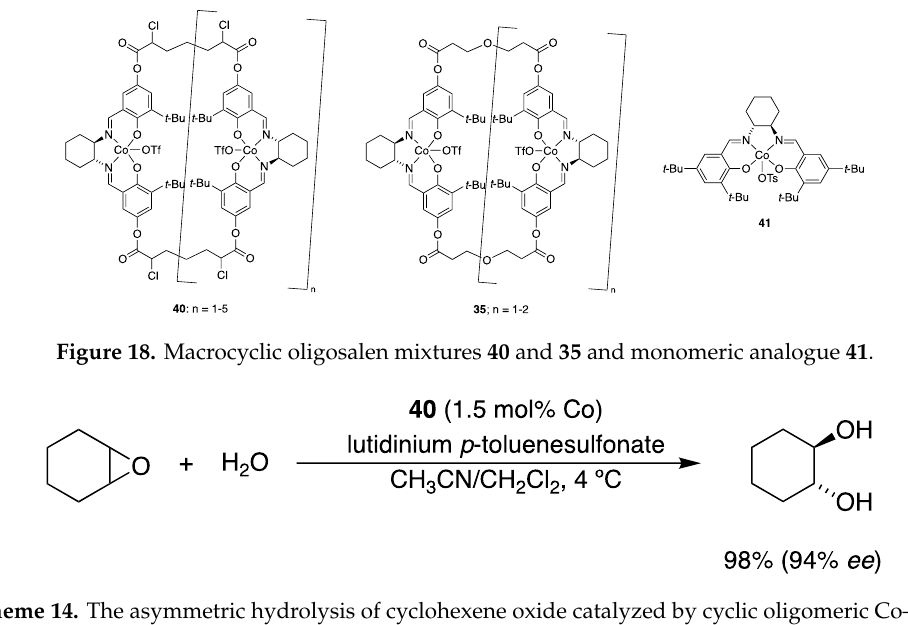
Scheme 14. The asymmetric hydrolysis of cyclohexene oxide catalyzed by cyclic oligomeric Co–salen complex 40 (Figure 18).